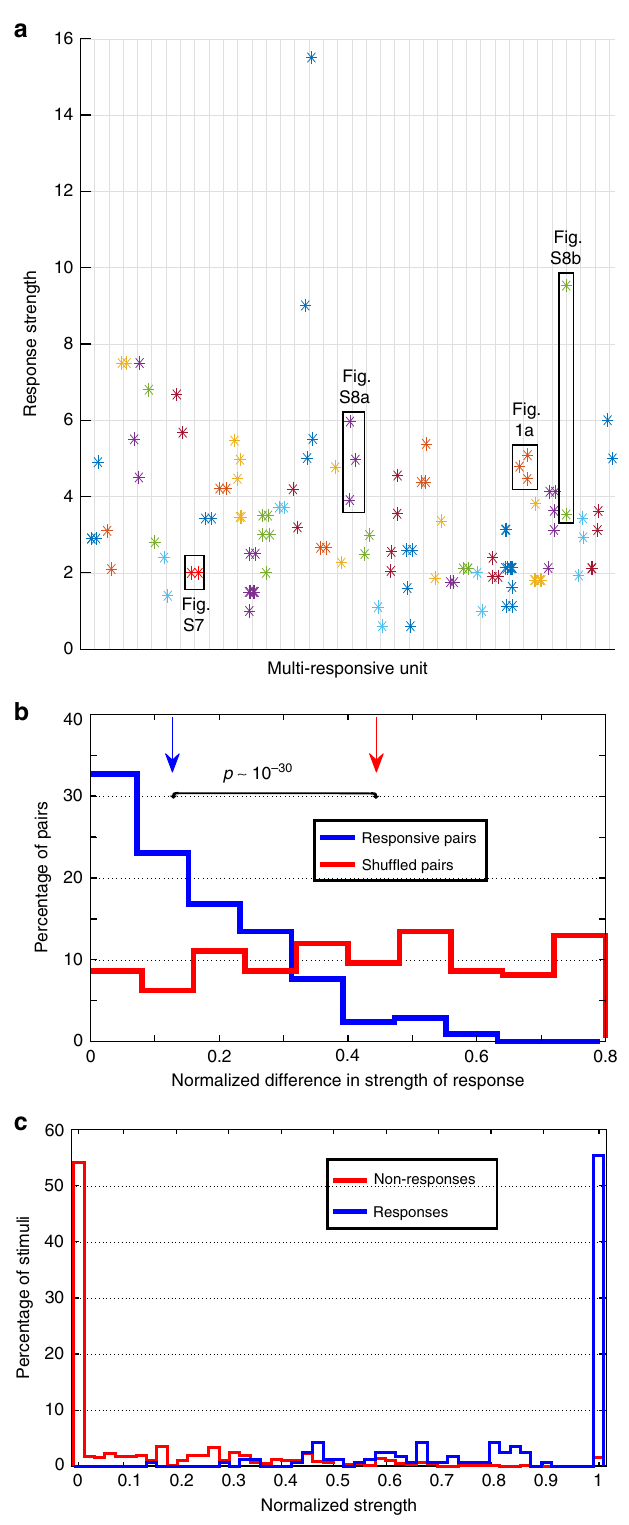
top panel of Supplementary Fig. 4 shows that the estimate became stable when using more than 11 trials. Moreover, the bottom panel shows that differences when considering more trials were not due to the order in the trial sequence (e.g., due to habituation effects). In fact, the estimation based on trials 1 to 6 was not signi fi cantly different than the one based on trials 20 to 25 (paired sign test, p = 0.93).